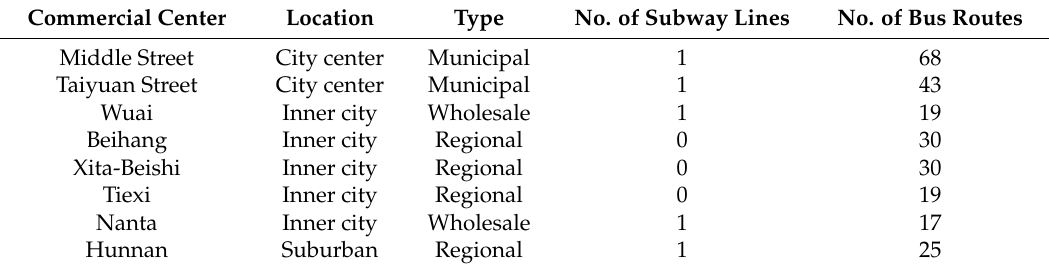
Figure 1. Location of Shenyang city and eight commercial centers. Table 1. Characteristics of the studied shopping centers.